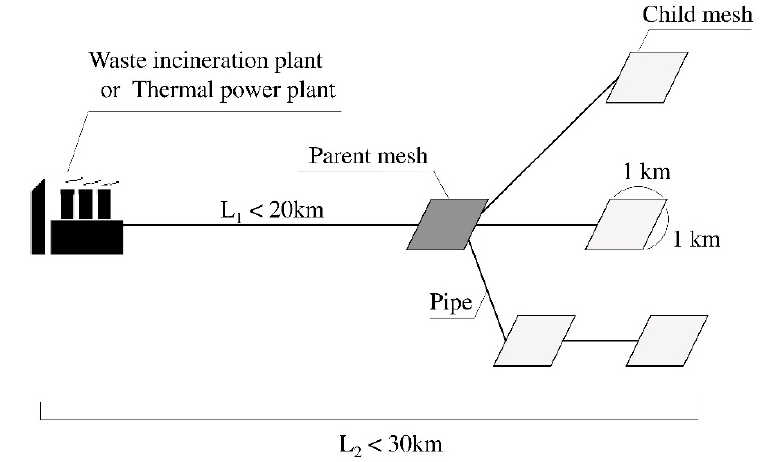
Figure 3. The model for designing the DHS.